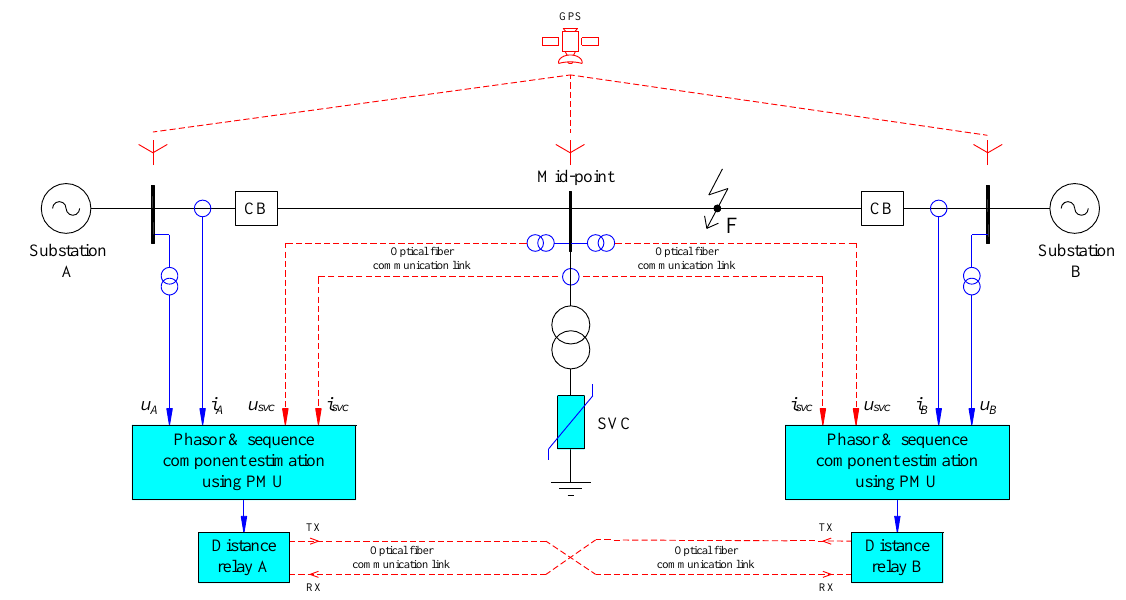
Figure 1. The one-line diagram of the study power